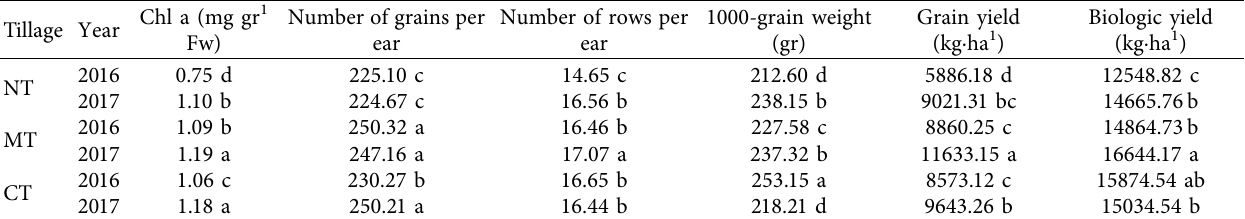
Table 3: Comparison mean the effect of different tillage on quantitative and qualitative traits of maize in two